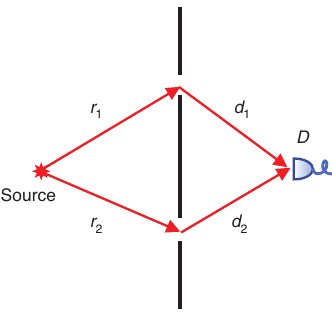
Figure 1: Schematic of Young’s double-slit setup. Here, r and r represent the distances from the source to the 1 2 upper and lower slits, respectively. The distances from the upper and lower slits to the detector D are represented by d